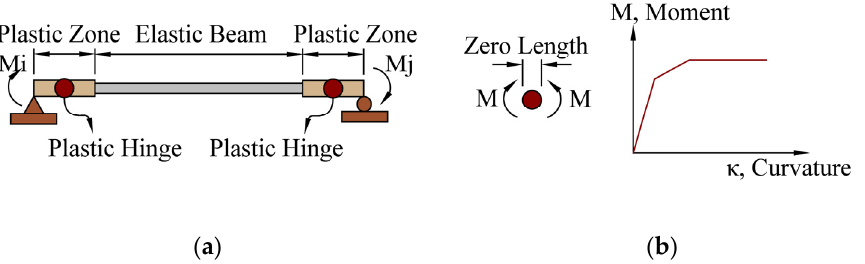
Figure 13. Plastic hinge beam–column element. ( a ) Schematic diagram, ( b ) moment–curvature relationship.